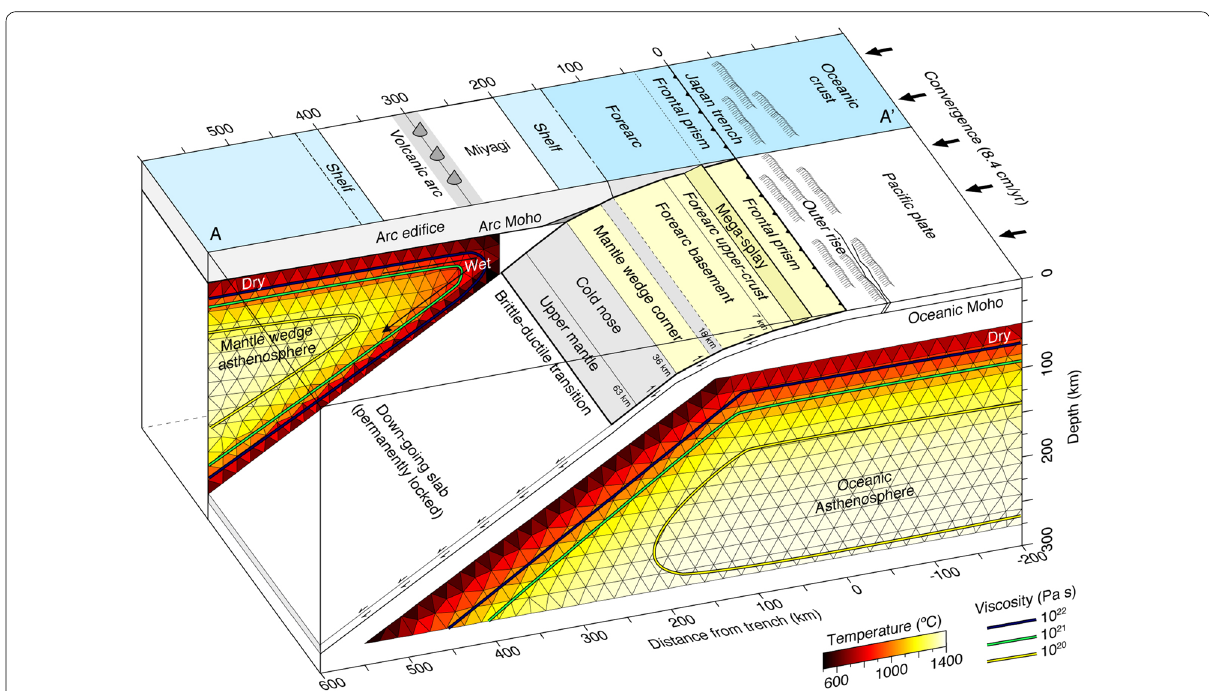
Fig. 2 Down-dip segmentation of the megathrust and physical parameters in the viscoelastic substrate used in the simulation of seismic ruptures, aseismic slip, and viscoelastic flow at the Japan trench (Miyagi). The cross-section corresponds to the profile A–A’ in Fig. 1. The velocity-weakening and velocity-strengthening segments of the megathrust are shown in yellow and gray color, respectively. Coupling between the two plates is permanent below the brittle–ductile transition. The ambient temperature in the oceanic asthenosphere and in the mantle wedge asthenosphere is shown with the background color. The triangle mesh is used for sampling of the viscoelastic deformation. Contours of steady-state viscosity for 10 20 Pa s, 10 21 Pa s, and 10 22 Pa s are shown with the yellow, green, and blue profiles, respectively. The small numbers at the corner of fault segments indicate their starting depth in the